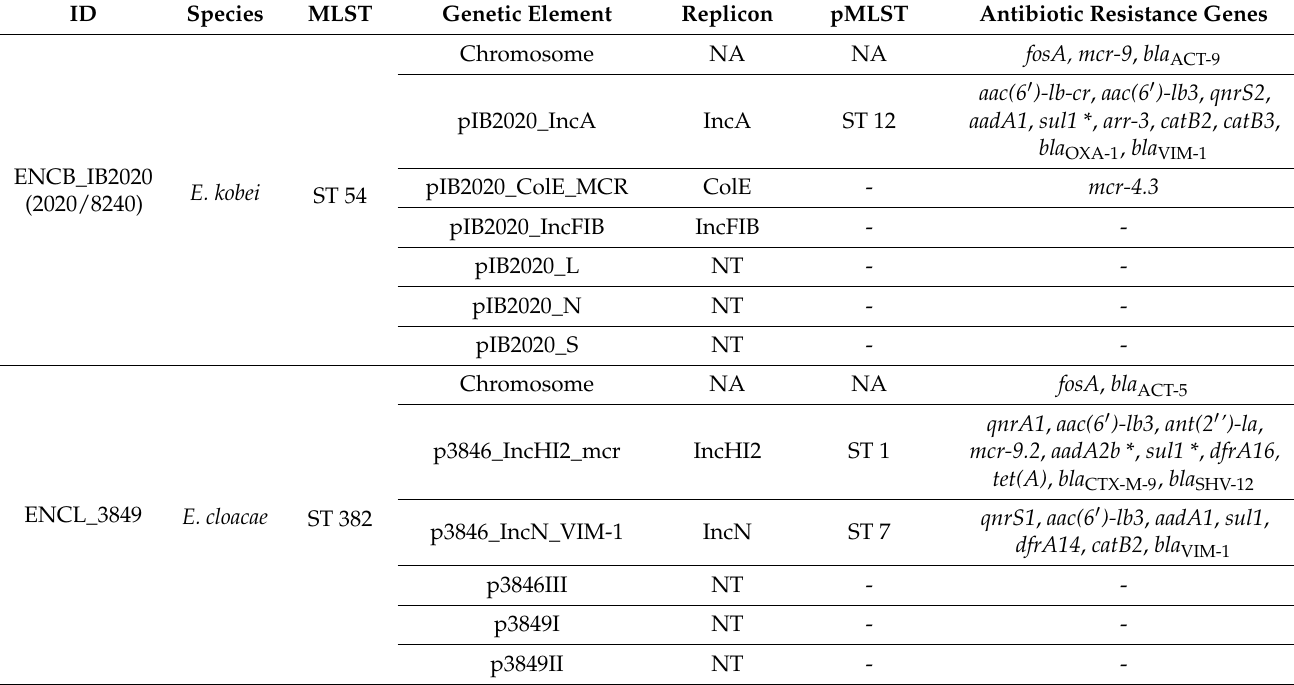
Table 2. Whole-genome characterization (WGS) analysis of the two MCR/VIM co-producing isolates from Italy. ID